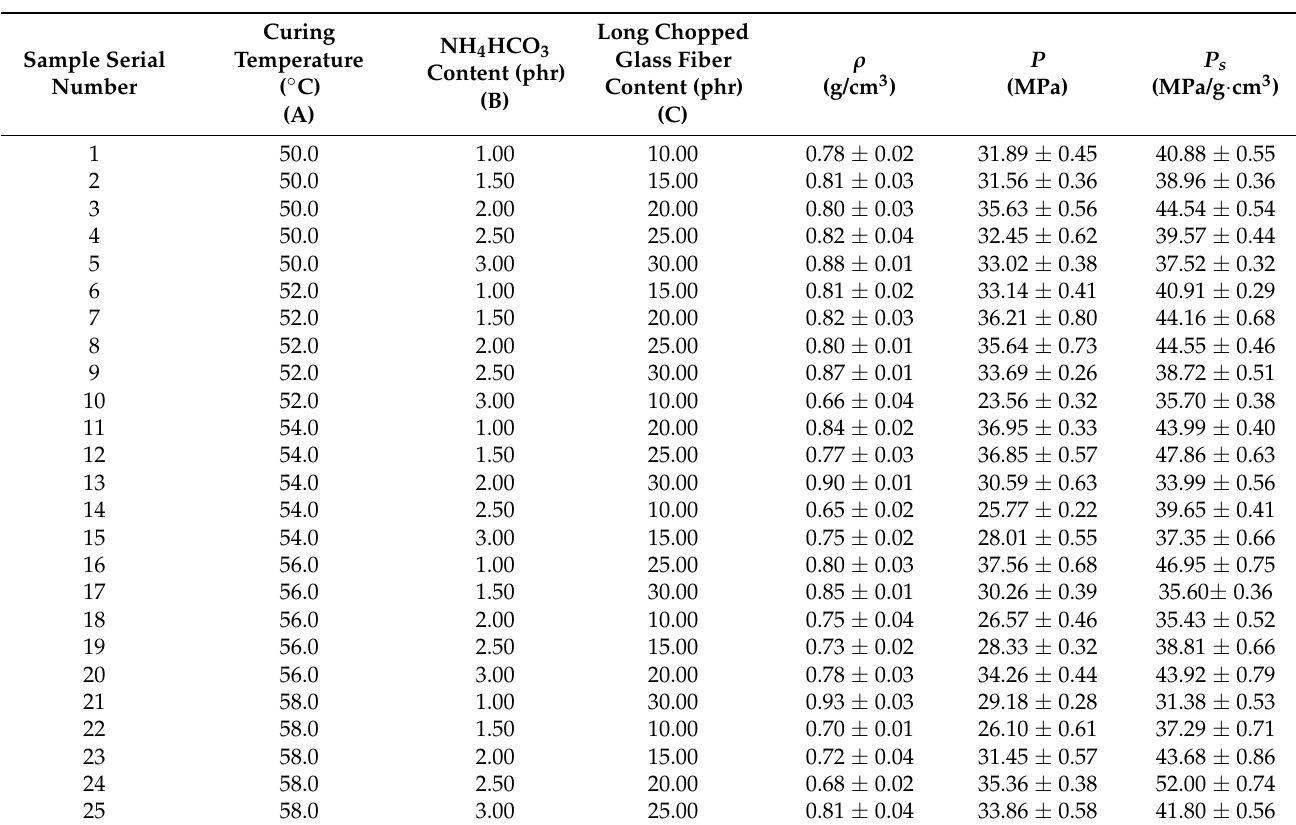
Table 2. Orthogonal experiment design and results of LCGFR-LDUPR composite samples.